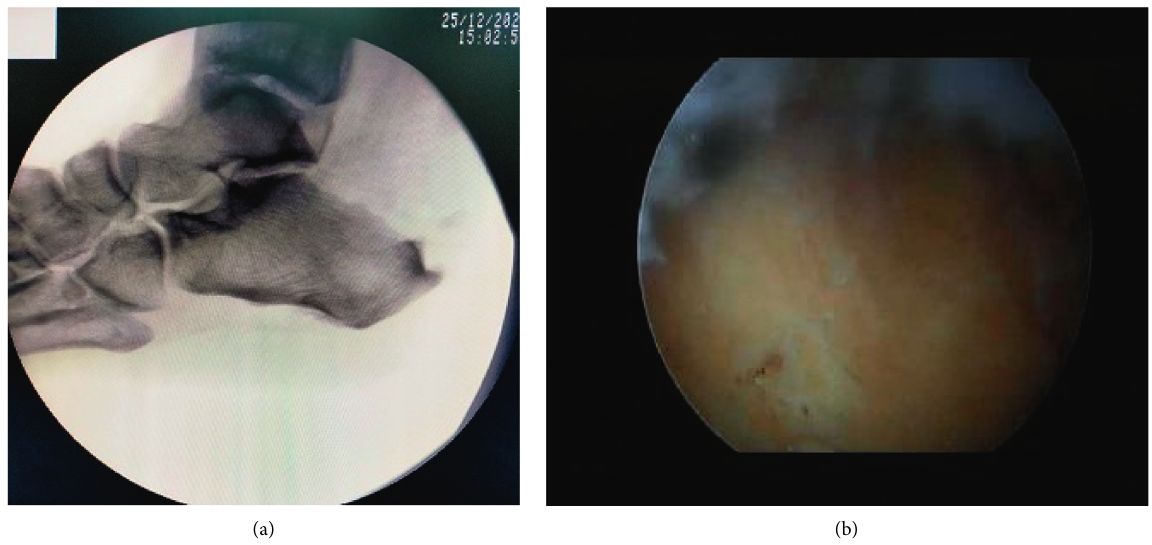
Figure 5: Intraoperative fluoroscopic (a) and arthroscopic (b) images showing complete resection of the excess bone.